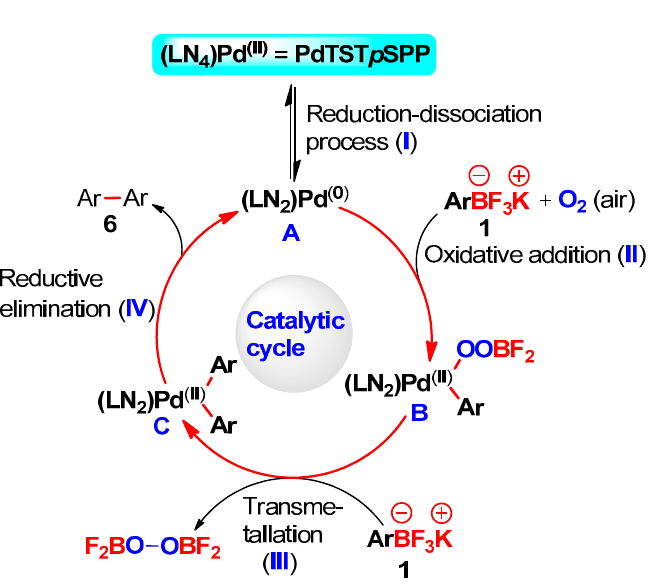
Table 3. Comparison of self-couplings of